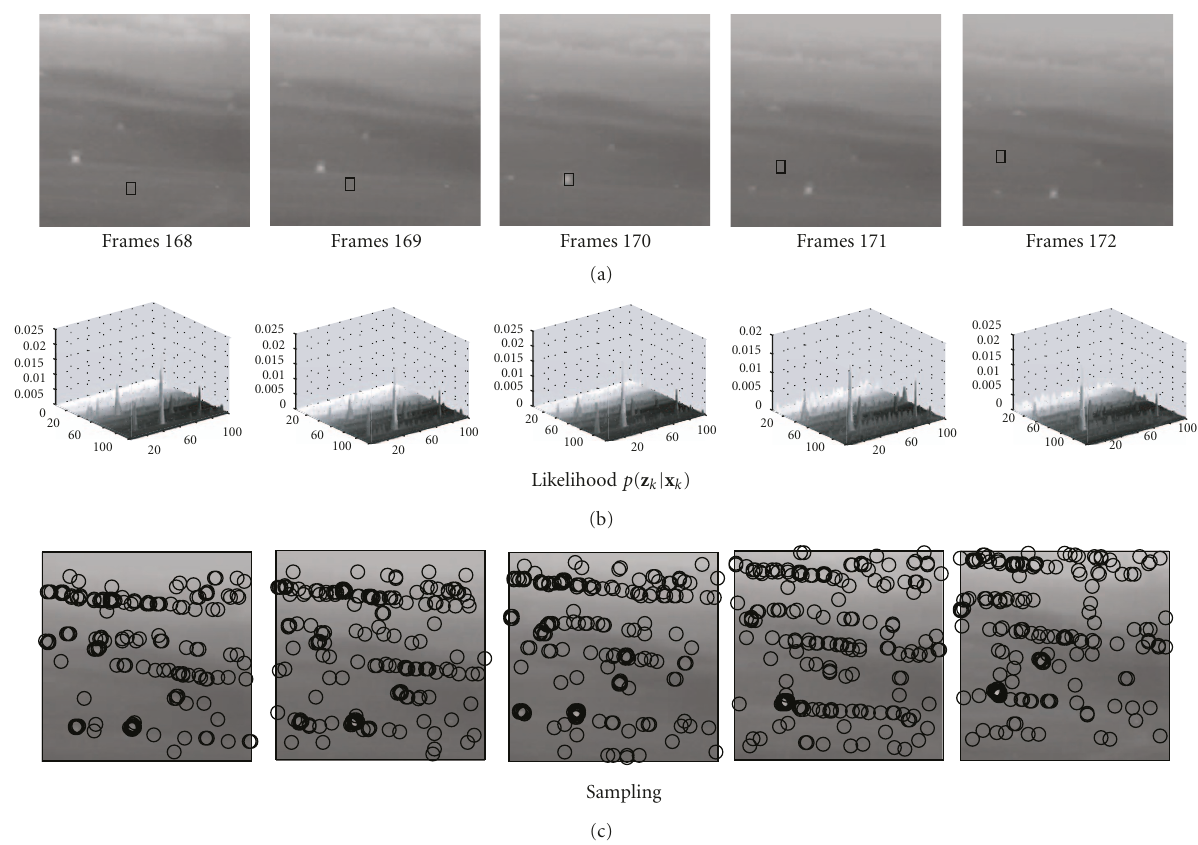
Figure 15: Common intermediate results for all the three tracking algorithms in a situation where the ego-motion compensation is especially challenging due to the aperture